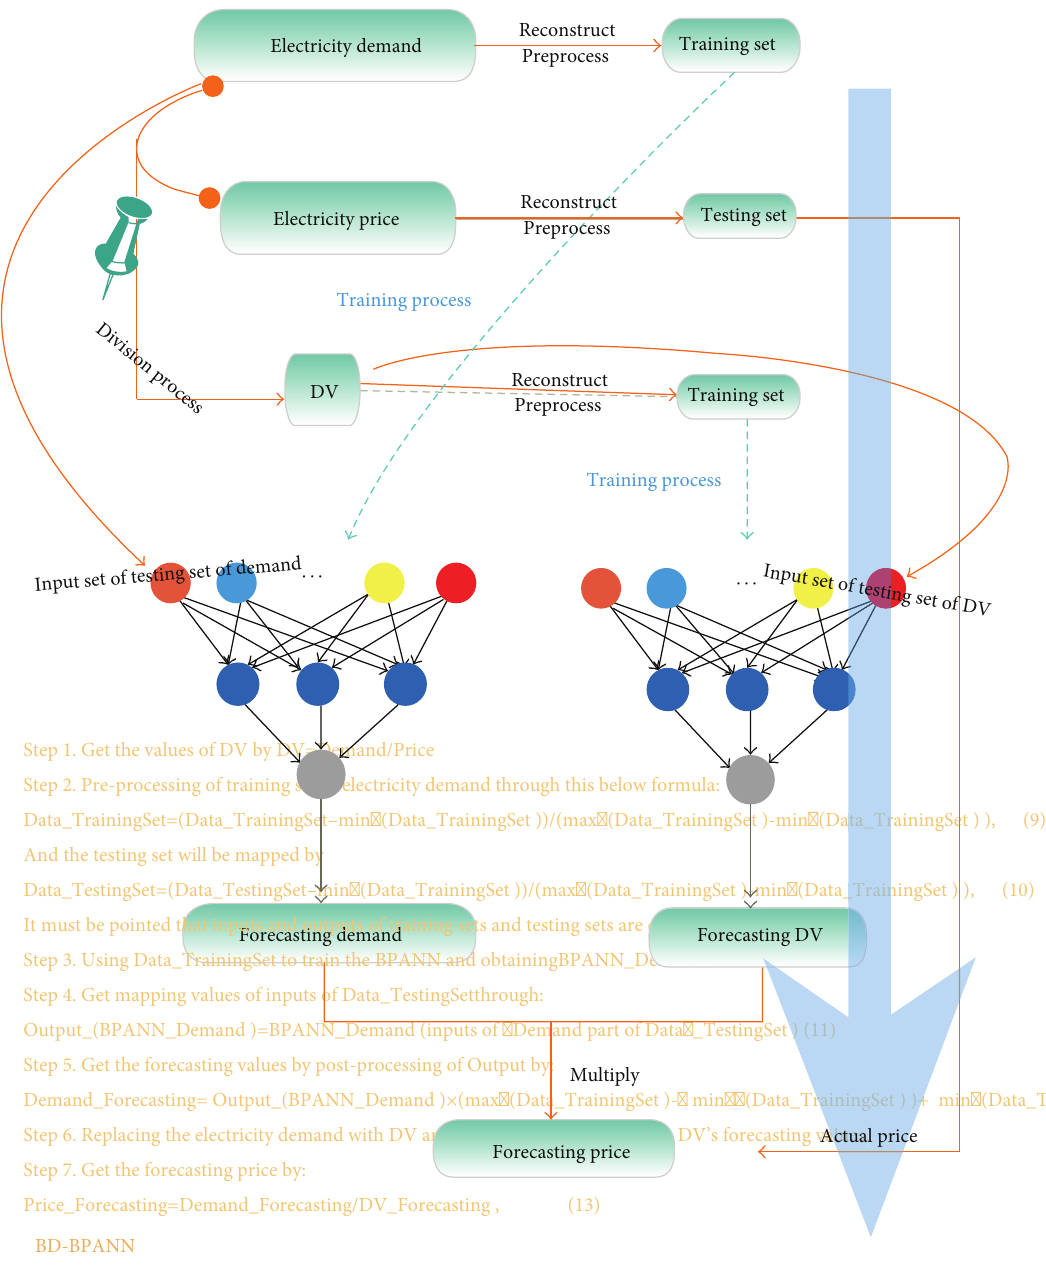
Figure 1: BD-BPANN